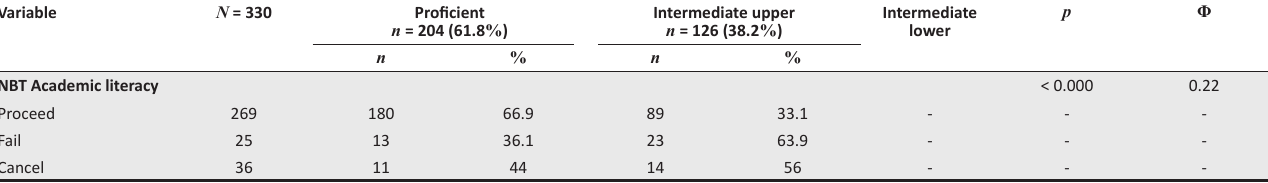
NBT Academic literacy